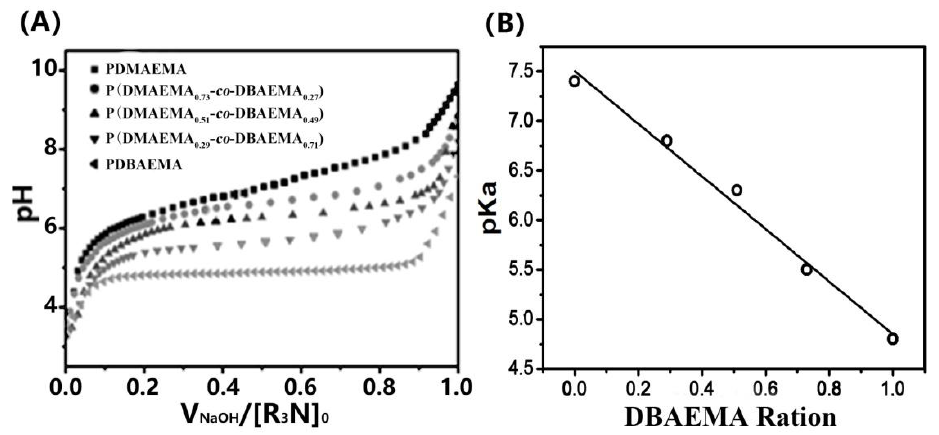
Figure 2. ( A ) pH titration curves of (co)polymers. The volumes of NaOH (V NaOH ) were normalized to the initial amount of amine ([R 3 N] 0 in mmol); ( B ) pKa values of the tertiary amine-based polymers as a function of DBAEMA ratio.